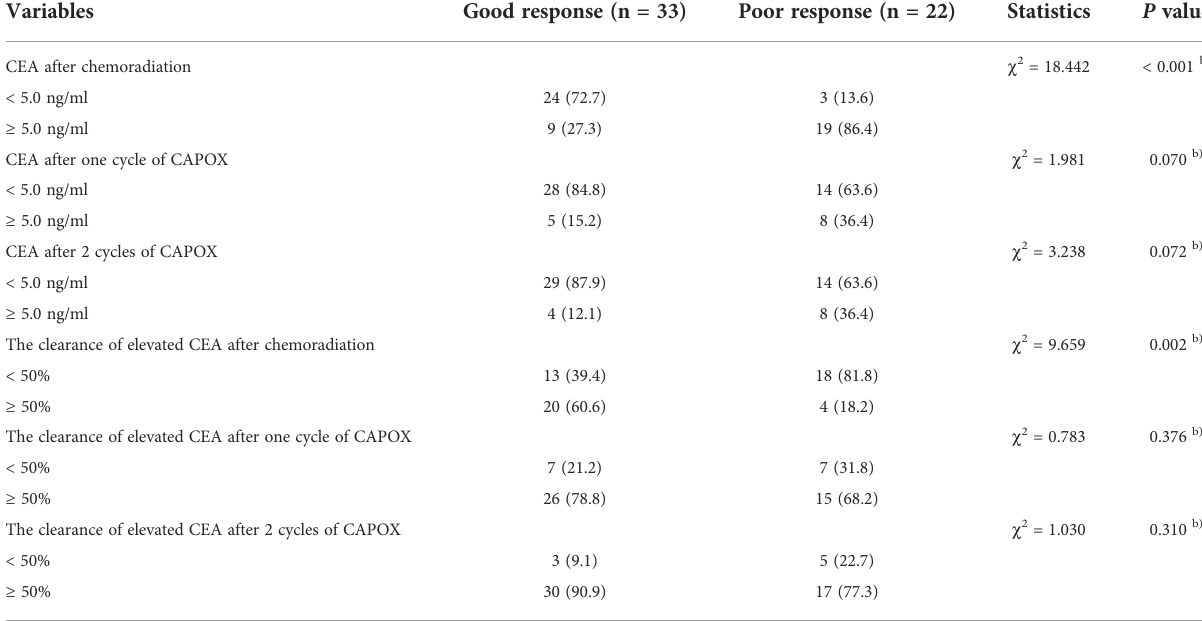
TABLE 2 Changes of carcinoembryonic antigen in patients with elevated carcinoembryonic antigen during total neoadjuvant